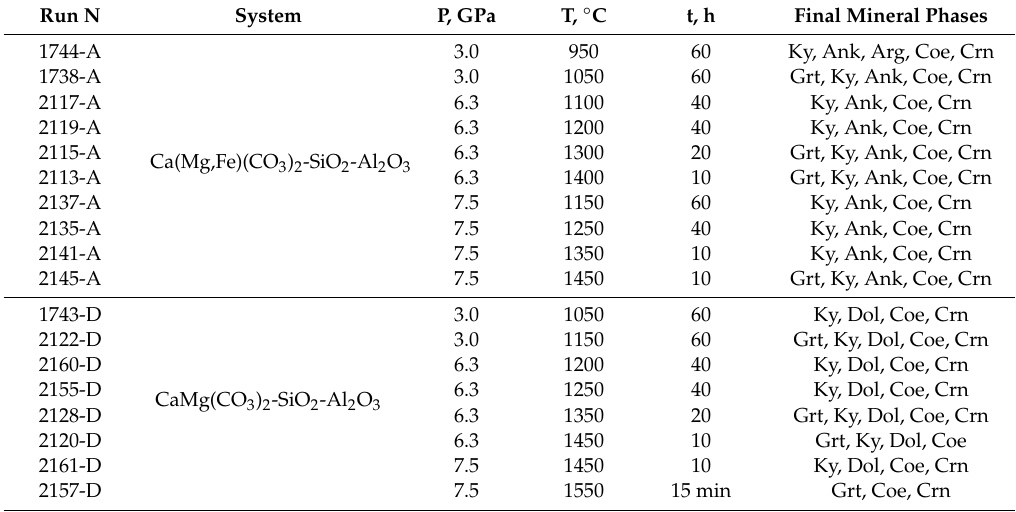
Table 2. Experimental parameters and